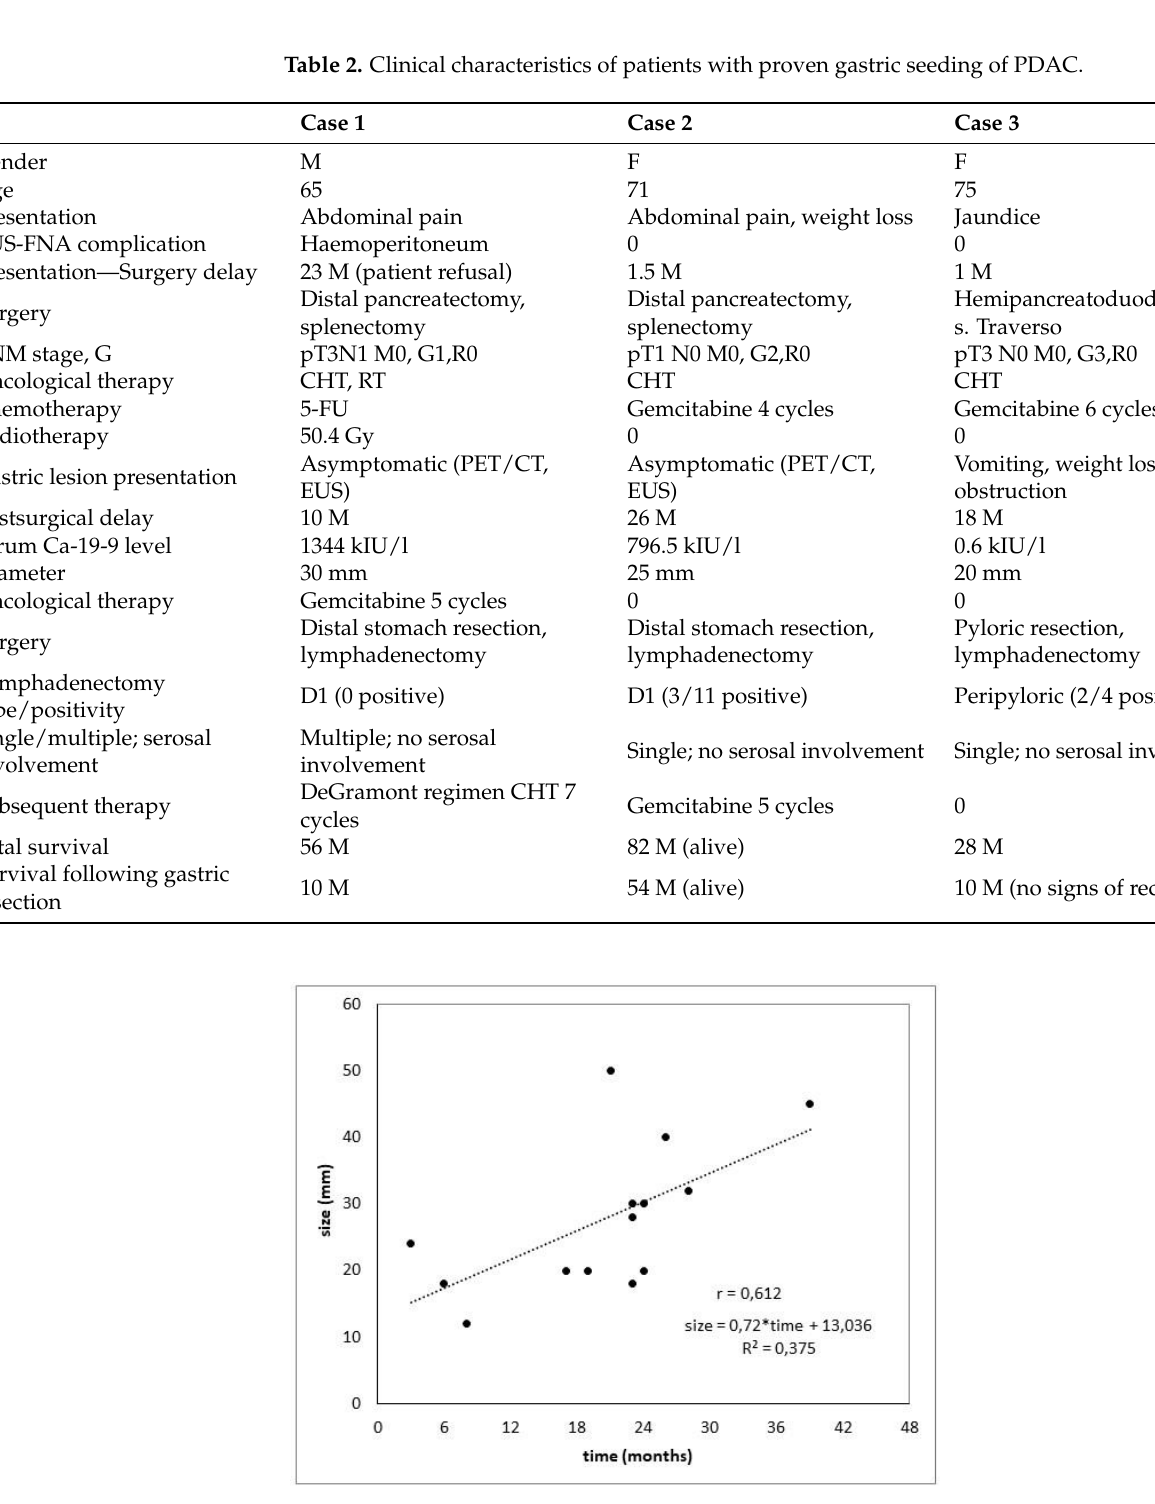
Figure 4. The correlation of time from the EUS-guided FNA and the size of gastric seeding metastasis. Table 3. Reported cases of needle tract seeding metastasis after EUS-FNA for pancreatic adenocar- cinoma.